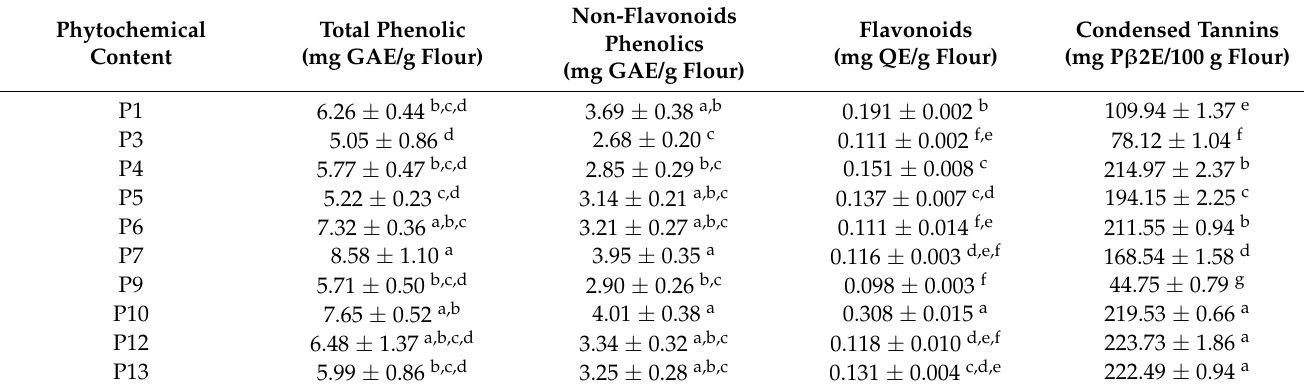
Table 2. Phenolic components of the seed flour from 10 clones of Prosopis alba